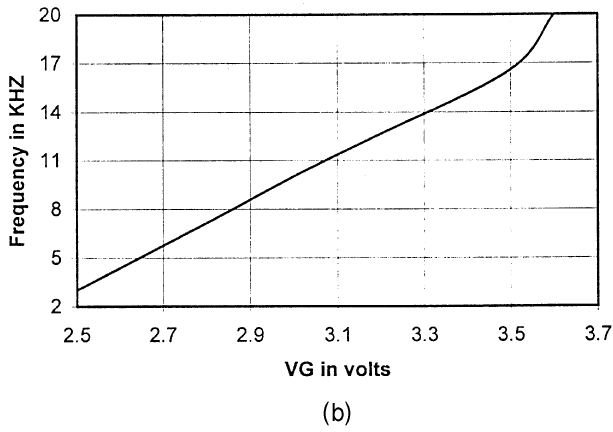
FIGURE 4 (b) Frequency tuning with gate voltage V